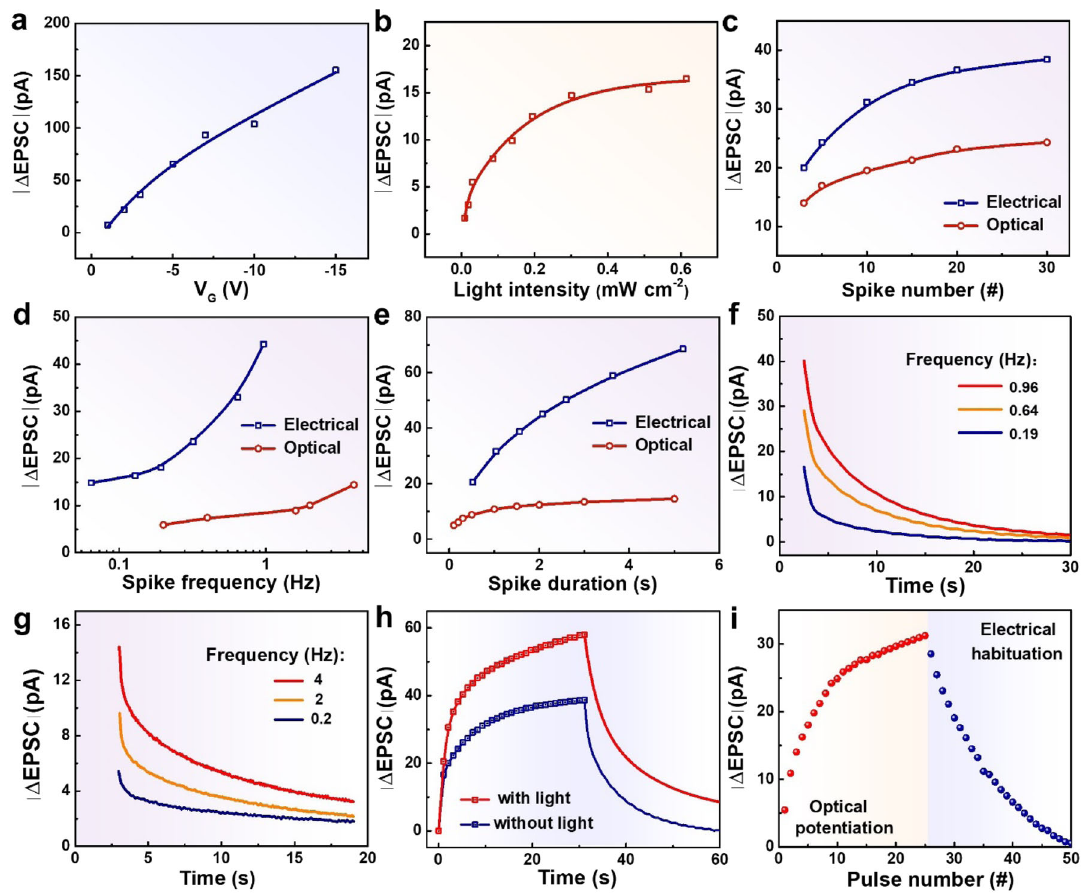
Fig. 3 Output characteristics of the optoelectronic synaptic transistor. a EPSC behaviors regulated by electrical spikes with different intensities of V G (0.5 s). b EPSC behaviors regulated by optical spikes with different light intensities (665 nm, 0.5 s). c EPSC behaviors regulated by electrical or optical spikes with different numbers (electrical spike: − 2 V, 0.5 s, 1 Hz; optical spike: 665 nm, 0.20 mW cm − 2 , 0.5 s, 1.43 Hz). d EPSC behaviors regulated by electrical or optical spikes with different frequencies (electrical spike: − 2 V, 0.5 s; optical spike: 665 nm, 0.20 mW cm − 2 , 0.2 s). e EPSC behaviors regulated by electrical or optical spikes with different durations (electrical spike: − 2 V; optical spike: 665 nm, 0.20 mW cm − 2 ). Memory decay processes after the training sequences with different frequencies under f electrical and g optical stimulations (electrical spike: − 2 V, 0.5 s; optical spike: 665 nm, 0.20 mW cm − 2 , 0.2 s). h Learning and memory behaviors induced by 30 electrical spikes ( − 2 V, 0.5 s) with and without light illumination (665 nm, 0.20 mW cm − 2 ), respectively. i Optical potentiation and electrical habituation characteristics subjected to a series of optical spikes (665 nm, 0.03 mW cm − 2 , 1 s) and electrical spikes ( − 0.5 V, 0.6 s) under the gate voltage of − 0.6